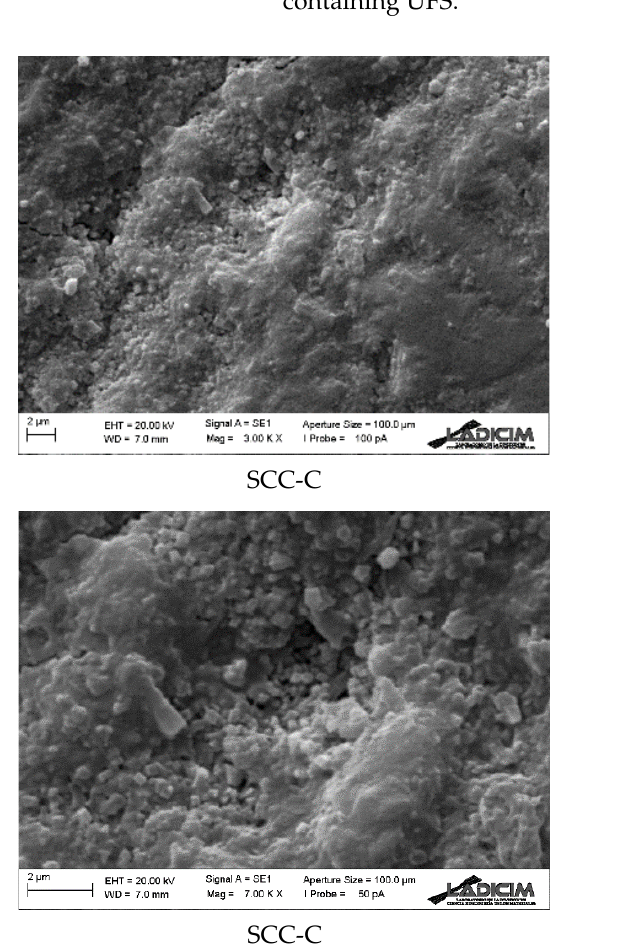
Figure 8. Micrographs obtained at 1500×.